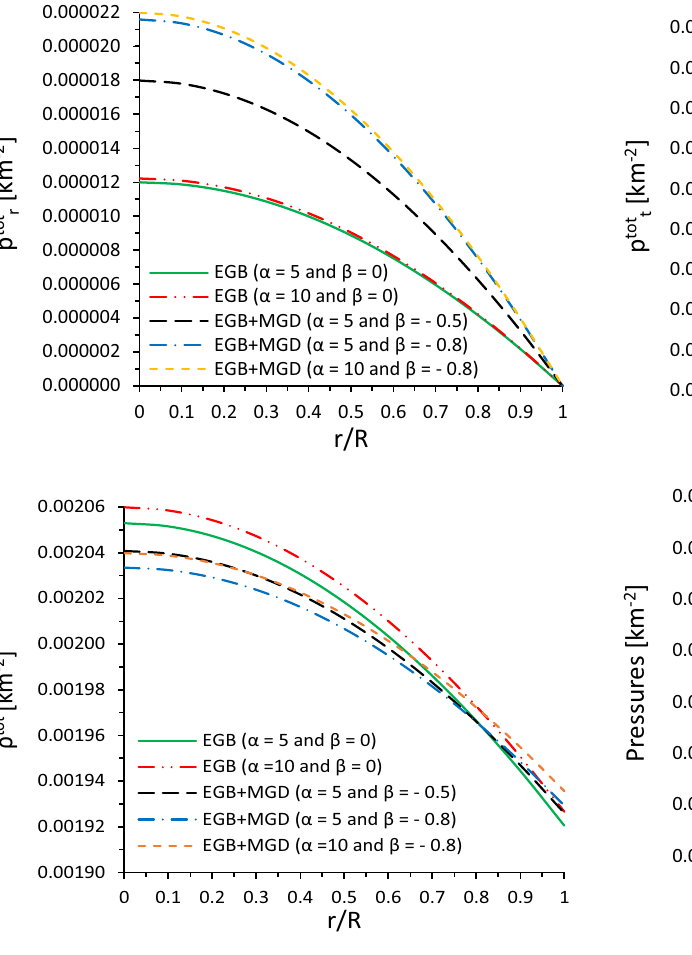
and tangential pressures with respect to r / R . We set the numerical val- = 0 . 2516 for plotting when α = 5 ues C = 0 . 000341 km − 2 and M EGB R